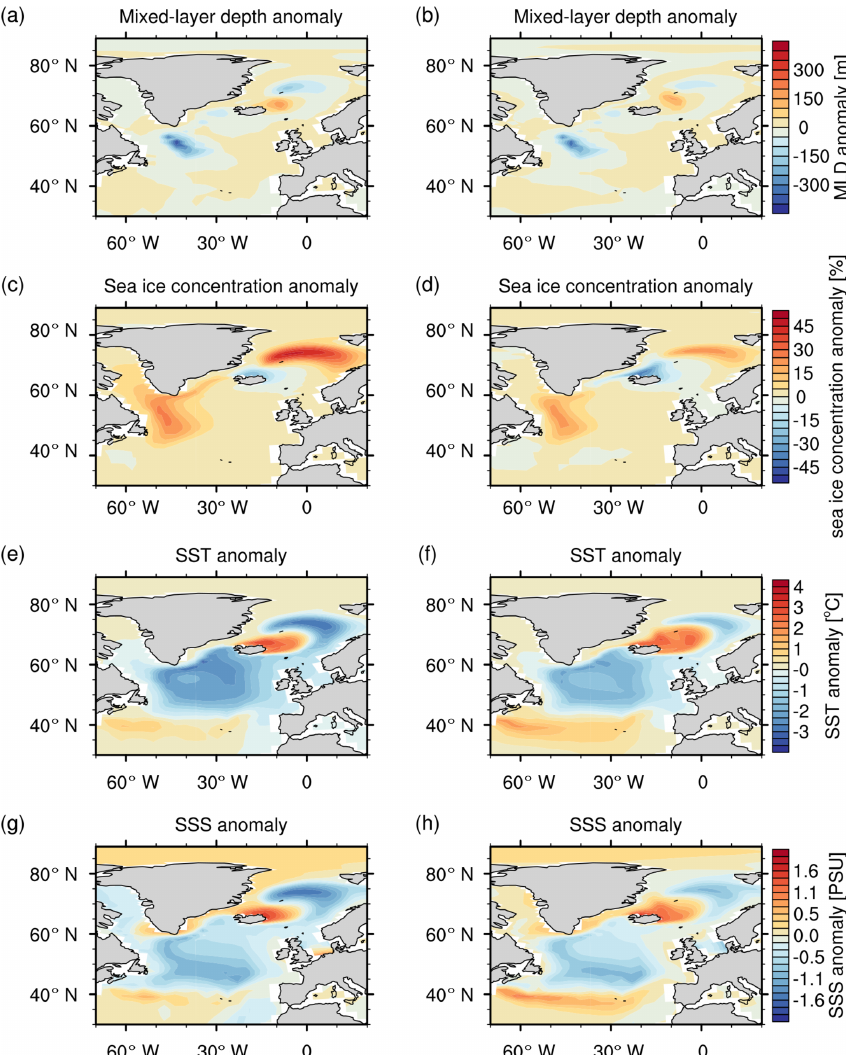
Figure 6. Difference maps for event 1 (left column; 4305–4267BP) and event 2 (right column; 3046–3018BP) of mixed-layer depth (m; a, b ), sea ice concentration (%; c, d ), sea surface temperature ( ◦ C; e, f ) and sea surface salinity (PSU; g, h